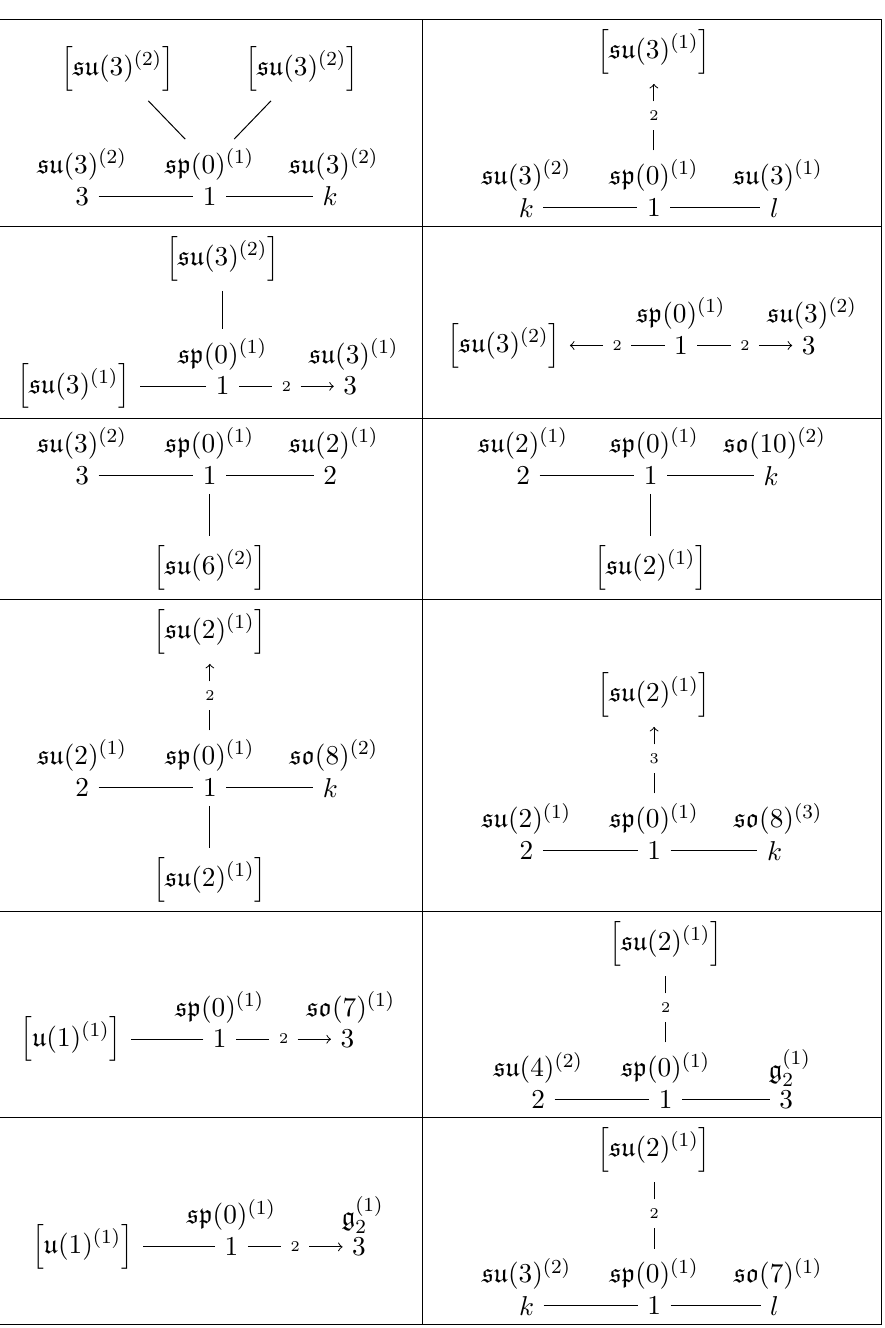
Table 10 . Continued from table 9: possible localized flavor symmetries in 5 d KK theories for nodes with a trivial gauge algebra having no incoming directed